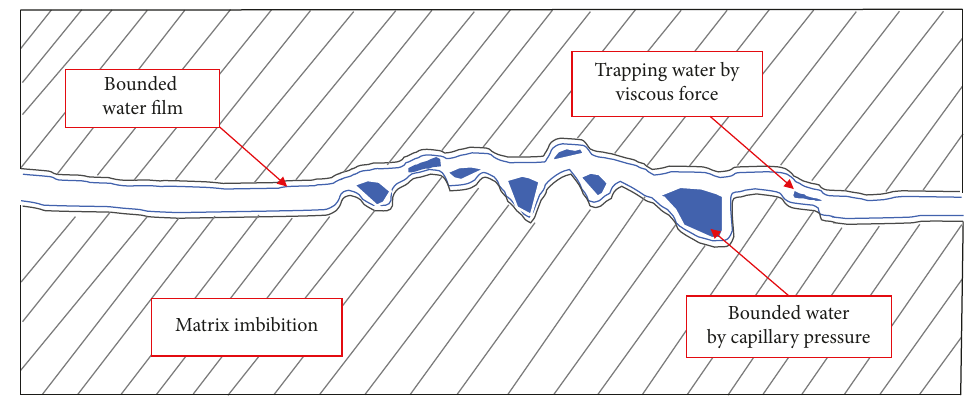
Figure 17: Fracture surface retention and viscous trapping in the